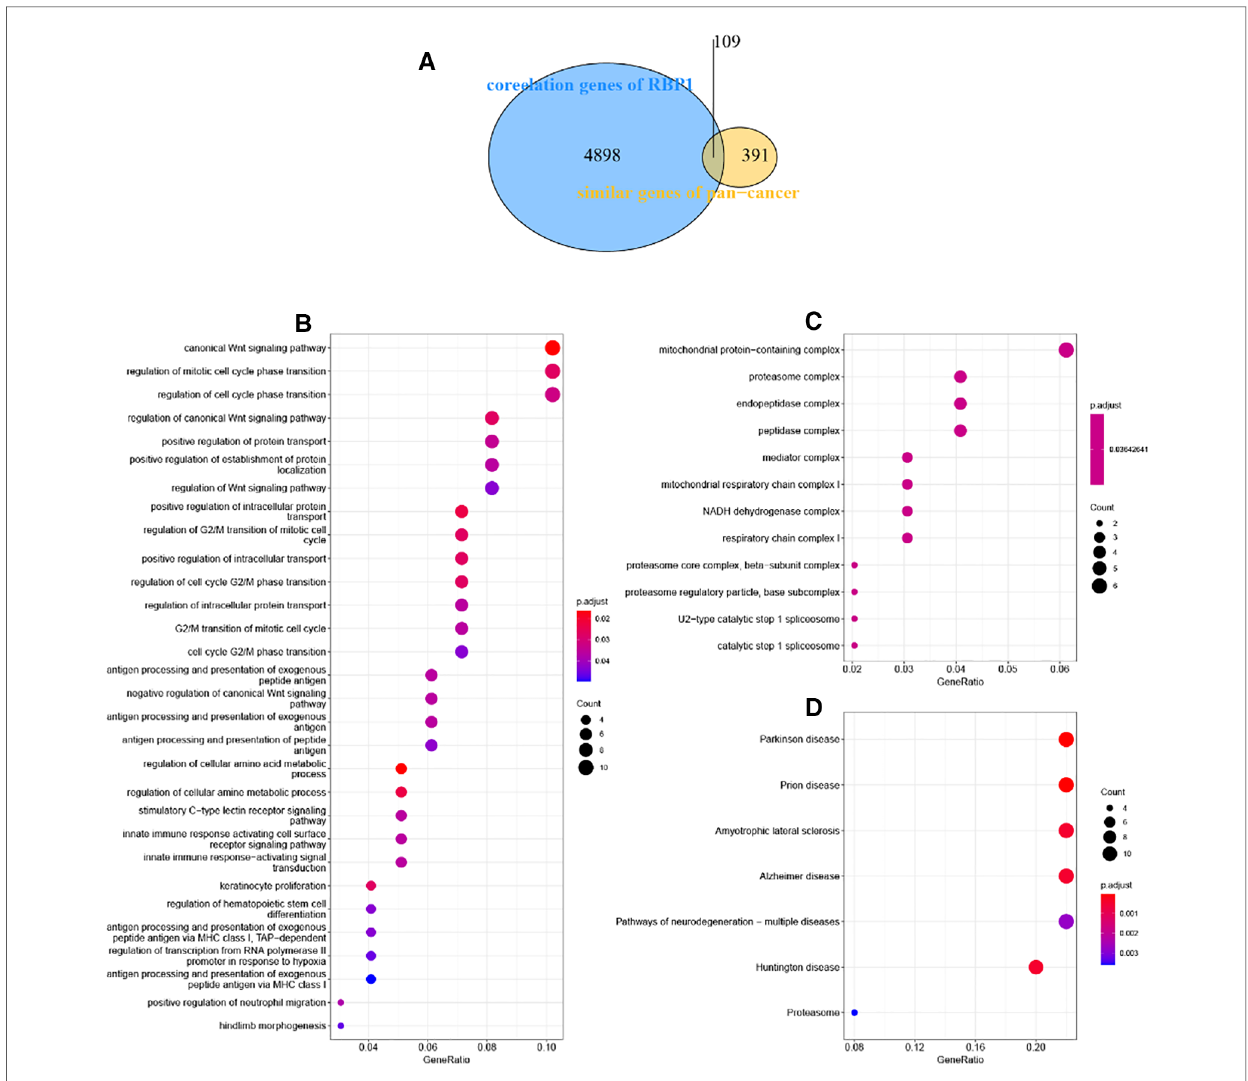
FIGURE 12 Enrichment analysis. ( A ) Venn diagram showing 109 similarly expressed pattern genes. ( B ) Biological process. ( C ) Molecular function. ( D )